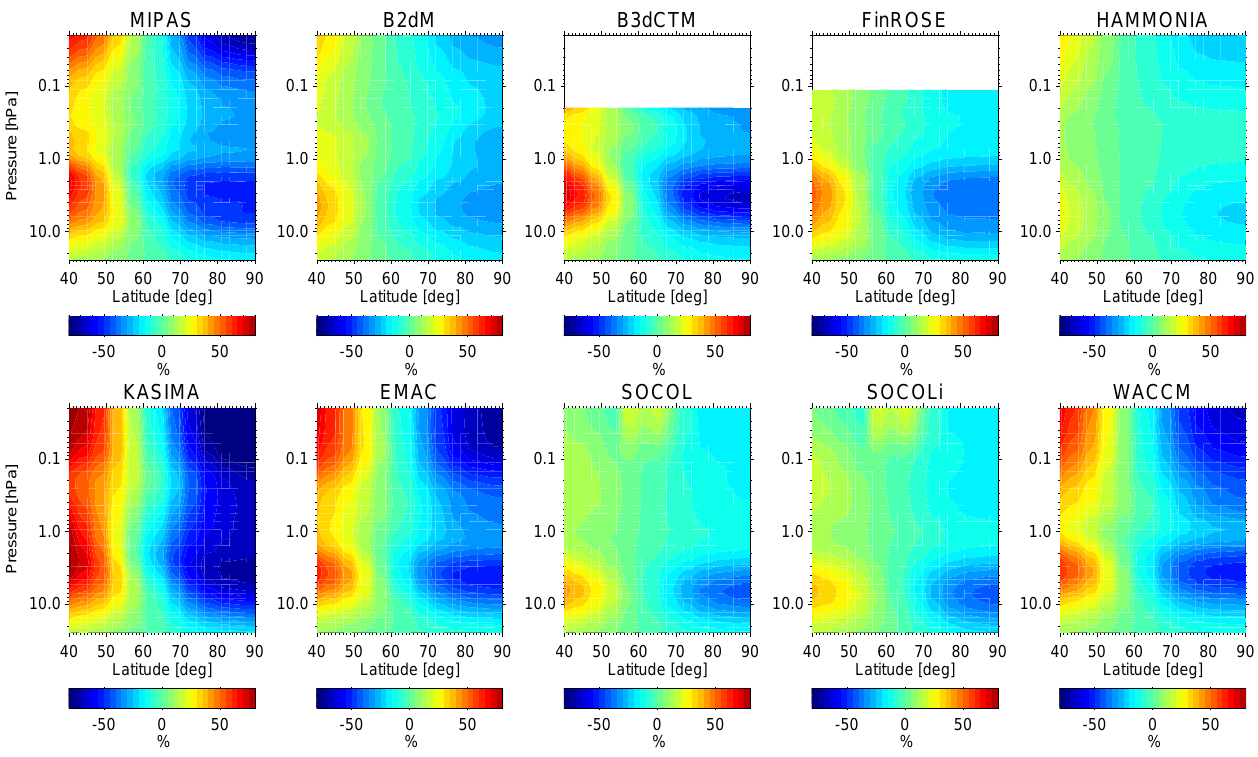
Fig. 9. Relative meridional CH 4 anomalies in MIPAS observations and model simulations at 40–90 ◦ N averaged over the whole time period. early winter vortex boundary. In general, the vortex bound- ary position is well reproduced by all models, although there are significant differences in the overall CH 4 change from mid-latitudes to the pole between the models. Strongest lat- itudinal gradients (i.e. weakest redistribution) were found in the KASIMA simulations, while smallest gradients